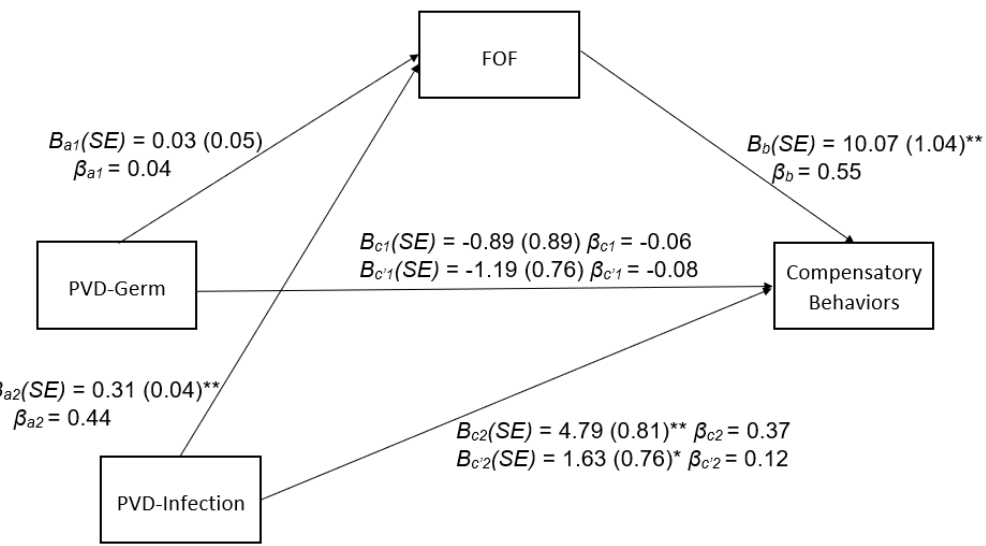
Figure 2. PVD Subscales and Compensatory Behaviors Mediated by FOF. Process Model — 4 path estimates from testing the indirect effect of perceived germ aversion (PVD-Germ) and perceived infectability (PVD-Infection) on compensatory behaviors through fear of fat (FOF). Standardized coefficients (β) , unstandardized coefficients ( B) and standard errors ( SE) are presented (* p < 0.05, ** p < 0.01).